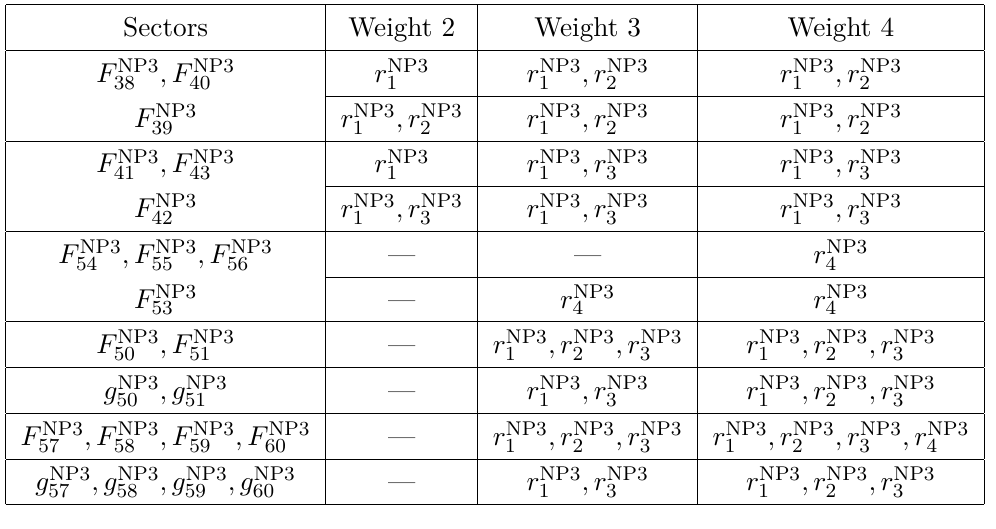
Table 2. Dependence of the basis integrals in some sectors on the square roots at different